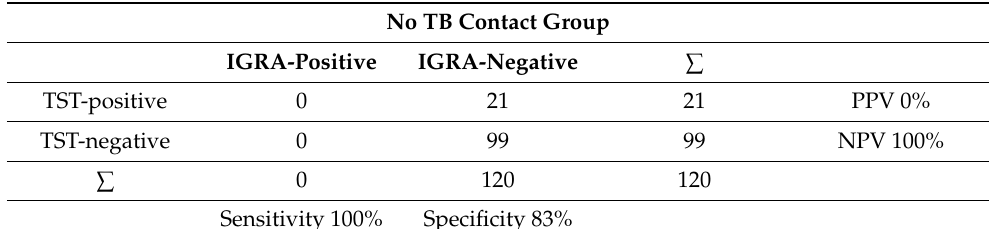
Table 4. Sensitivity, specificity, positive predictive value (PPV), and negative predictive value (NPV) for TST in correctly identifying IGRA positivity in no TB contact volunteers.